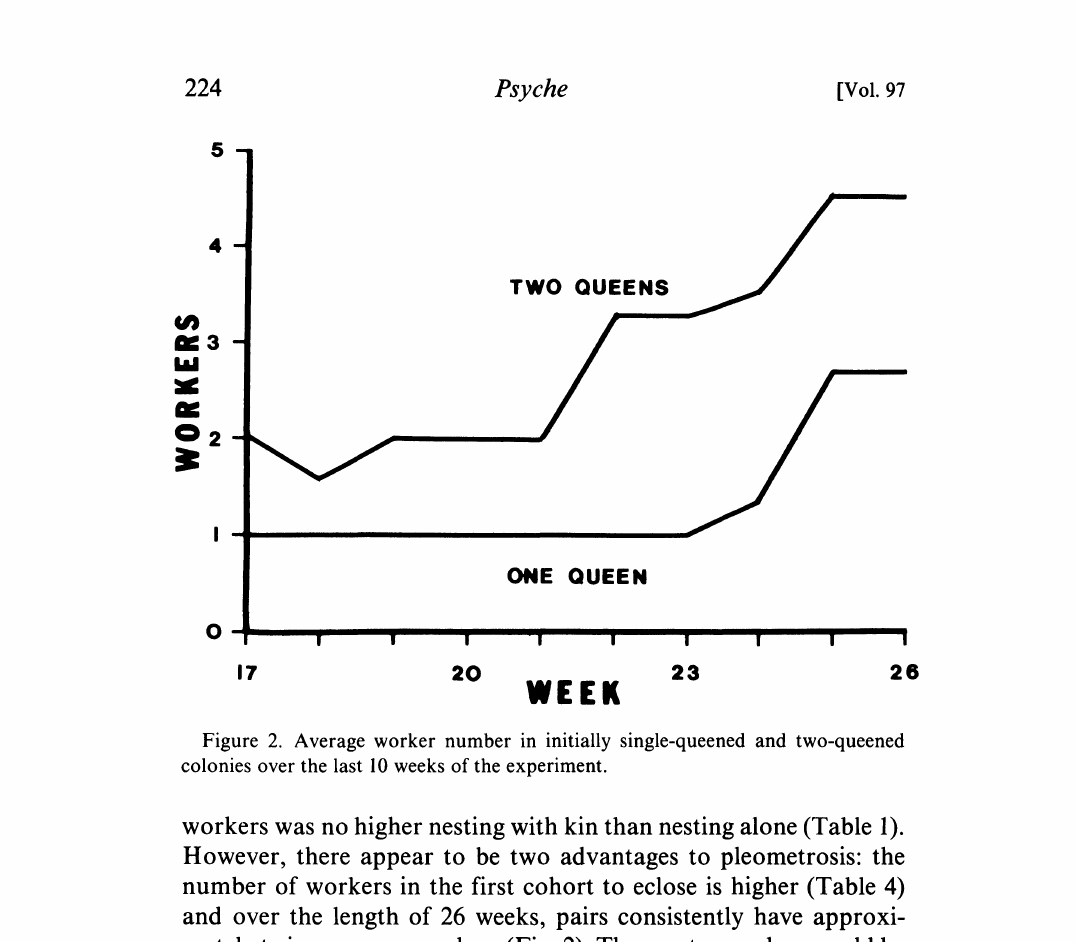
Figure 2. Average worker number in initially single-queened and two-queened colonies over the last 10 weeks of the experiment. workers was no higher nesting with kin than nesting alone (Table